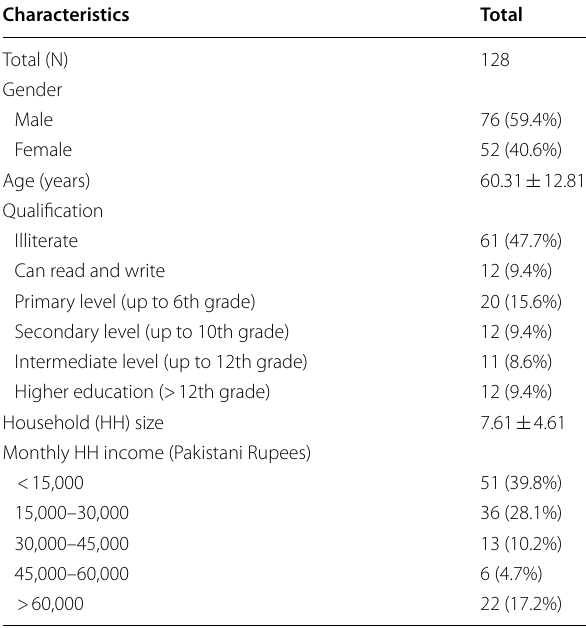
Table 1 Baseline demographic